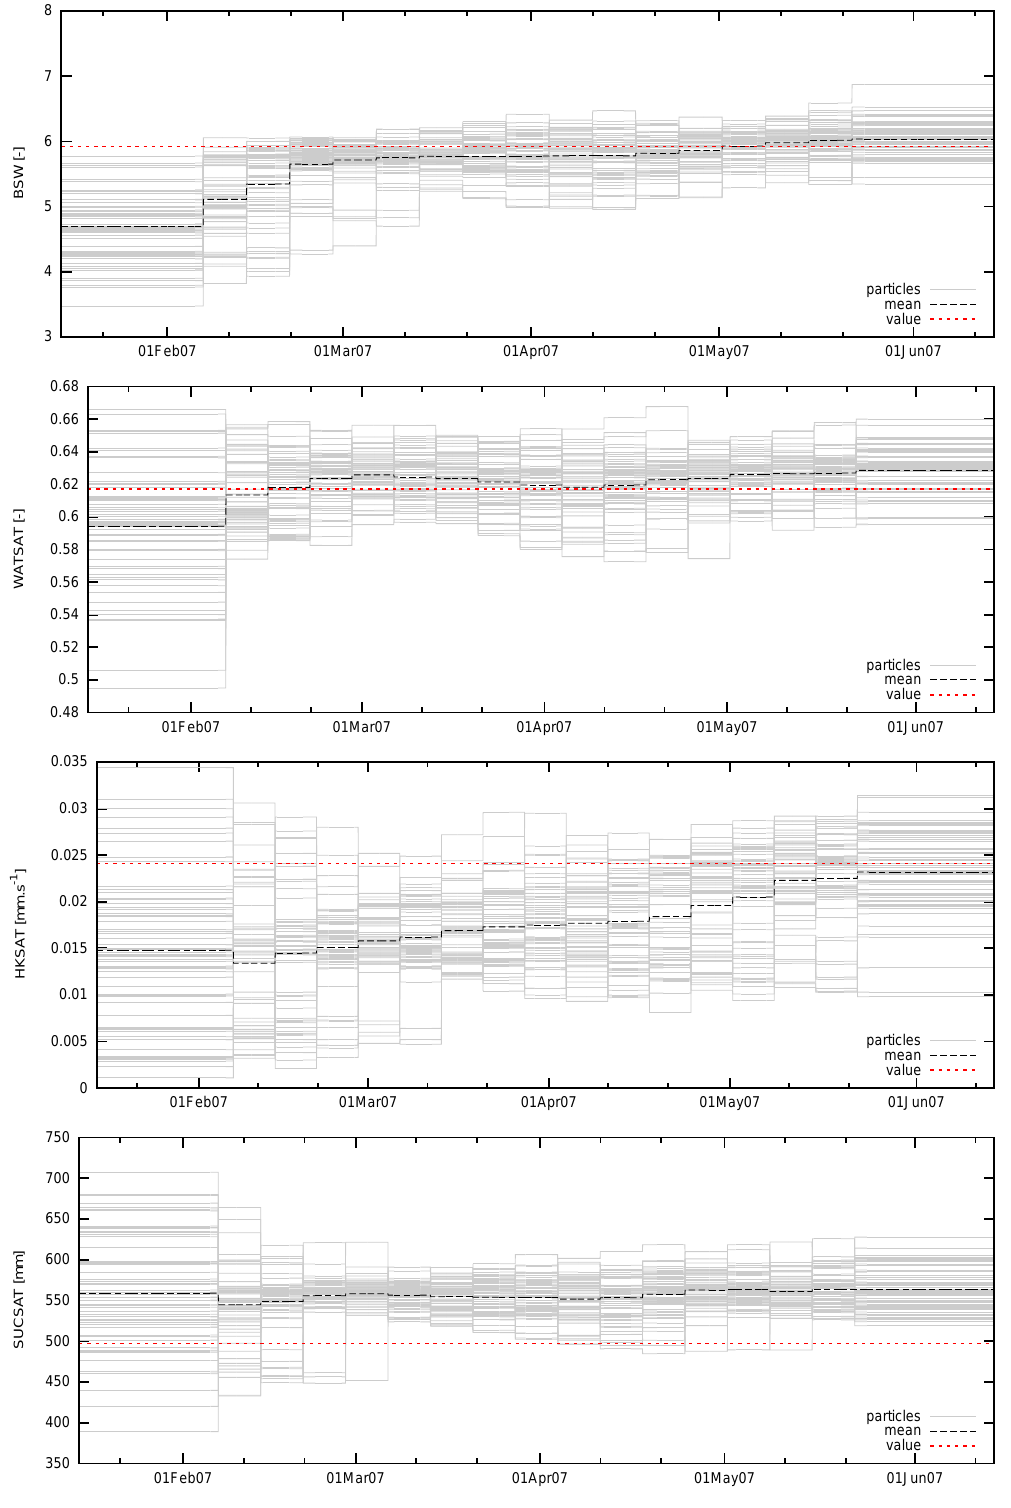
Fig. 9. Evolution in time of the soil parameters in the top layer when SISR-PR filter is applied with parameter perturbation. Hydrol. Earth Syst. Sci., 16, 375–390,